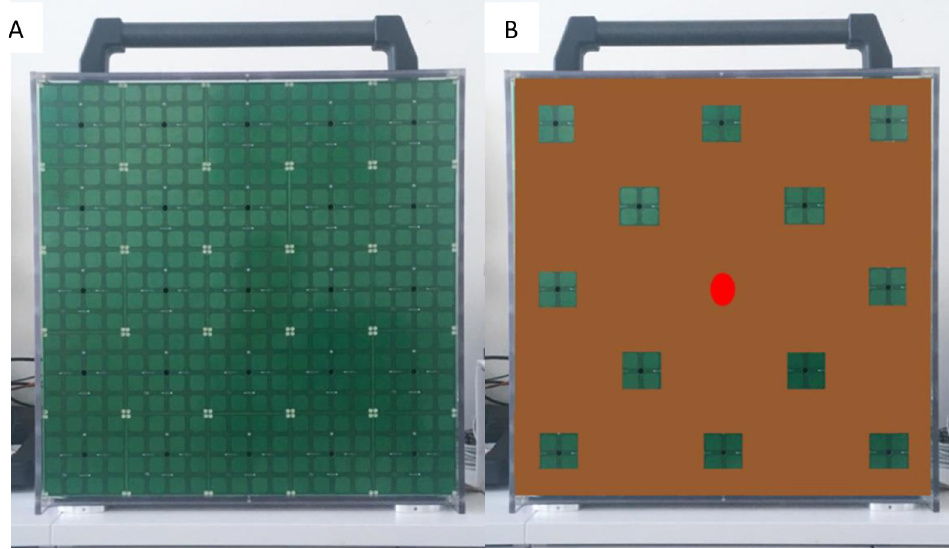
Fig 4. ARENA. A) The device measures 50 cm x 50 cm and consists of 25 speakers embedded in blocks covered by tactile sensors. Tactile sensors cover the blocks. B) The cardboard grid placed over the ARENA is represented. The grid is composed of 12 free slots. The feedback sounds were emitted from the speaker indicated by the red